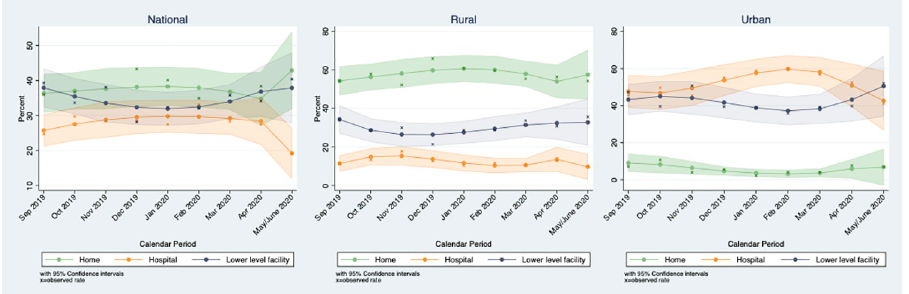
Fig 1. Percentage of births delivered at home, in a government hospital or in a lower-level health facility by month and residence.